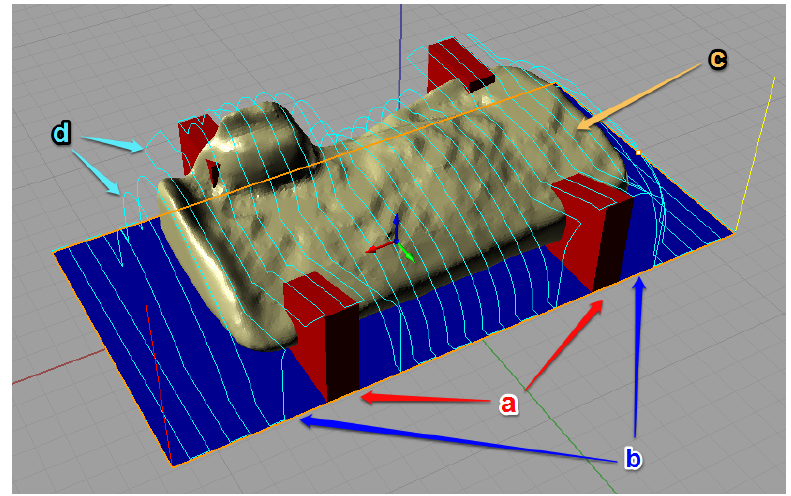
Figure 3. Tool-path trajectory planning: (a) added bone bridges; (b) work area; (c) graft design; (d) tool-path.